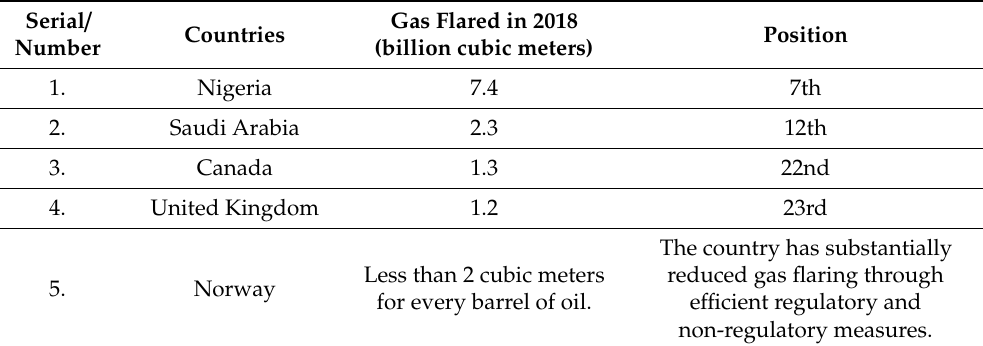
Table 1. The 2018 World Bank Ranking of the Selected Case Study Countries among Other Gas Flaring Countries in the World.